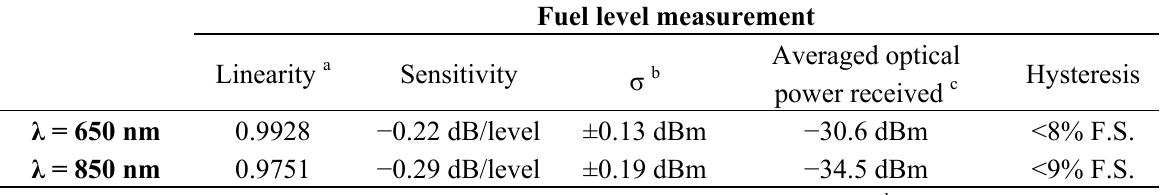
Table 3. Statistics of the experimental data in fuel level measurement for gauge-shaped fiber sensing probe at 650 nm and 850 nm, respectively.